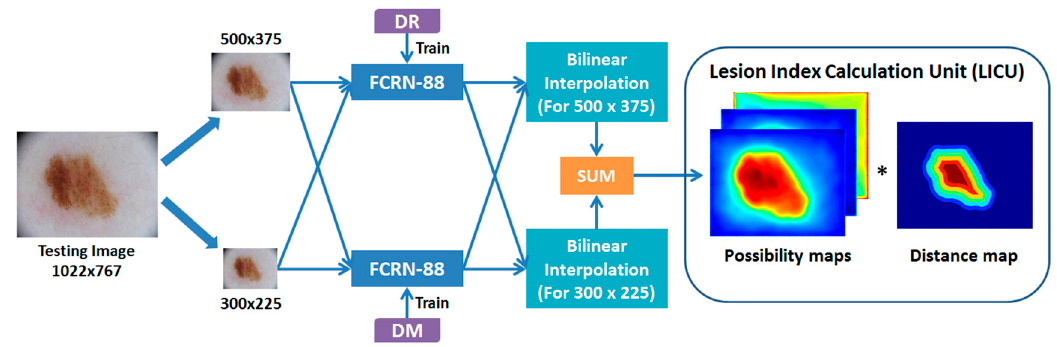
Figure 3. Flowchart of the Lesion Indexing Network (LIN). The framework contains two FCRN and a calculation unit for lesion index. (The numbers of image size are measured by pixels).